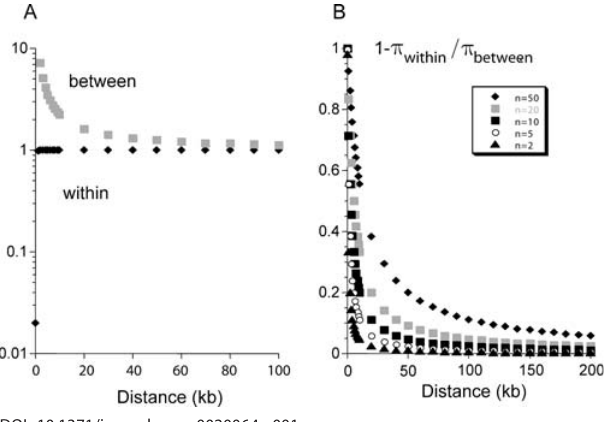
Figure 2. Lineages at a Locus under Long-Term Balancing Selection Two haplotypes with different alleles, A x and A y , which diverged before the common ancestor of two species (1 and 2), are denoted by black and grey lines and boxes, respectively (denoting genes). Variants in the regions in and around the selected locus will remain associated with the haplotype in which they arose until recombination occurs with a different haplotype, even after the species become isolated. Species– specific differences (shown as thin horizontal lines in the tree and vertical lines in the haplotypes) will also accumulate. Recombination between different haplotypes (indicated by mixed black–grey haplotypes) will mean that sites close to the selected sites will be most differentiated between alleles (see Figure 1).